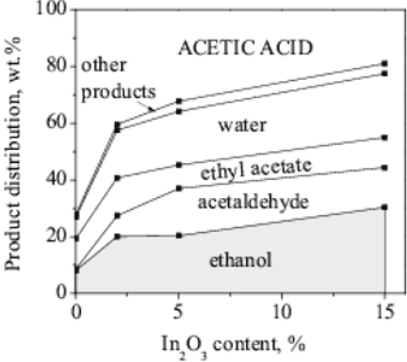
Figure 4. Comparison of 16CuA catalysts with various amounts of